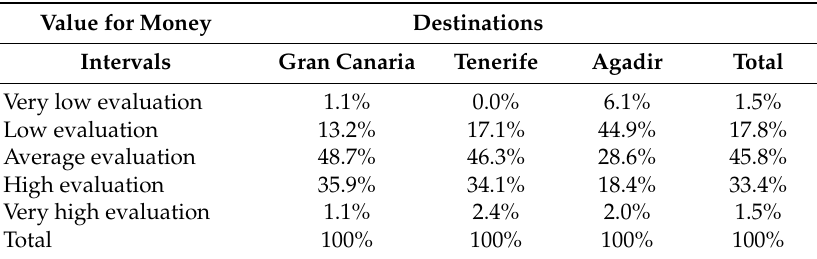
Table 8. Comparative analysis of the value for the money